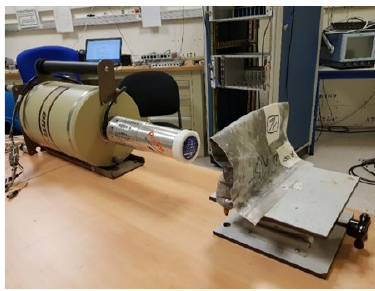
Fig. 2. Photon activation measurement: irradiation step.